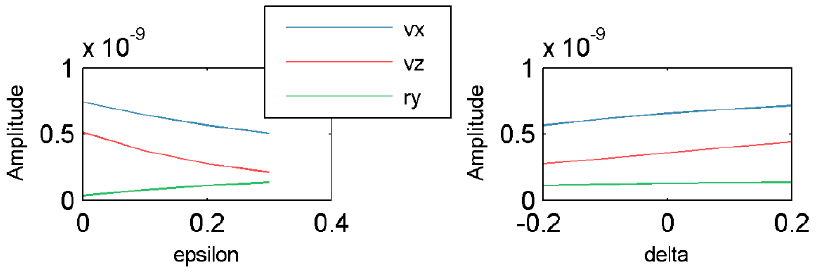
Figure 12. Influence of ε and δ on peak values of the 90th trace generated from the expansion source.